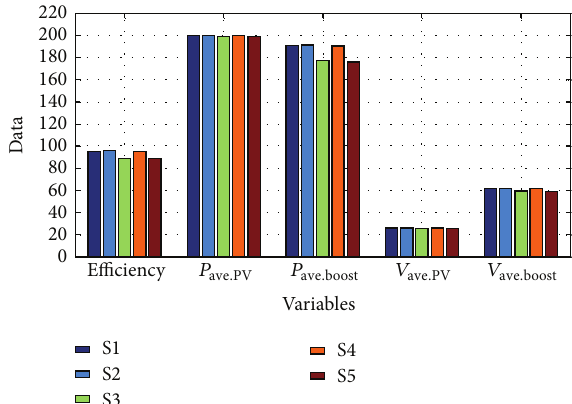
Figure 18: Boost output voltage at irradiation of 1000 W/m 2 and 25 ∘ C.